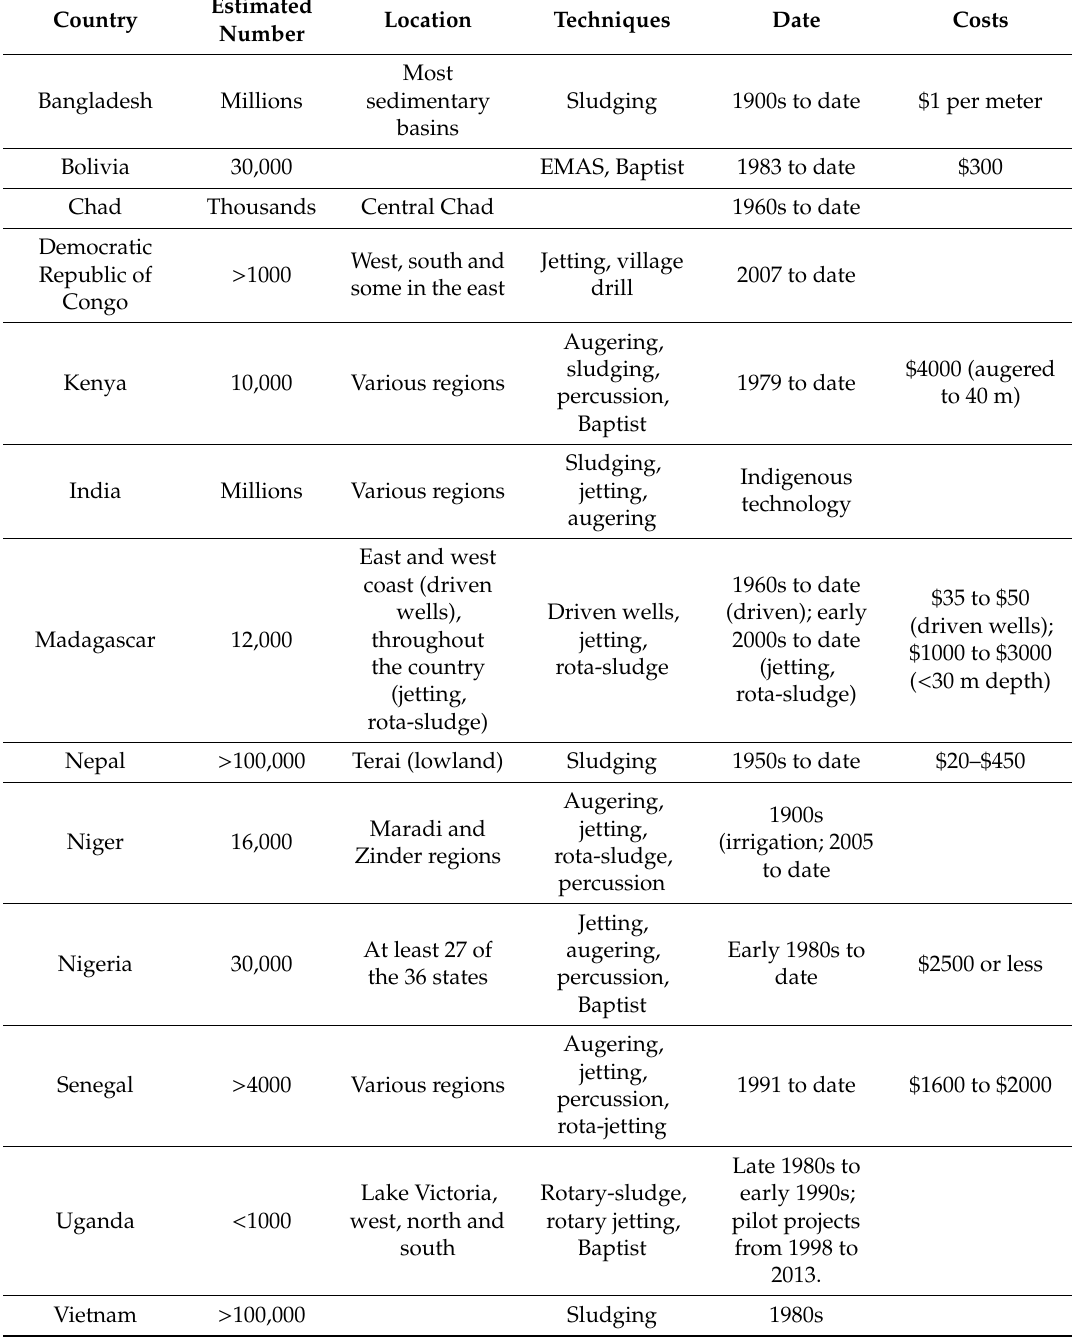
Table 2. Manual drilling in selected countries